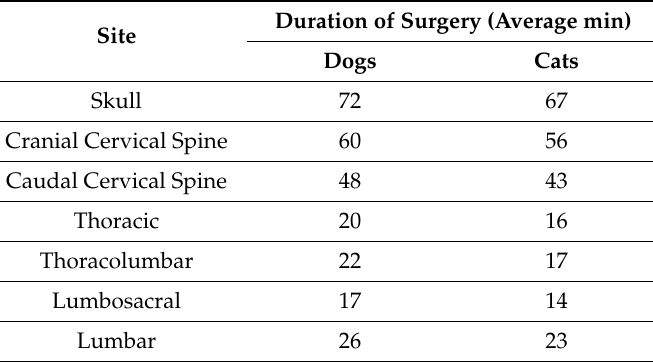
Table 4. Duration of surgical procedures.